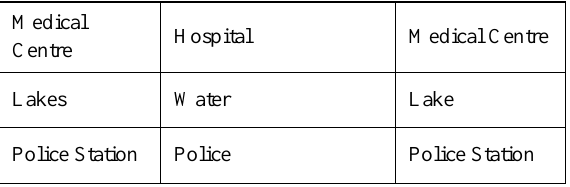
Table 2: Semantic matching between OSM and PPJ polygon features